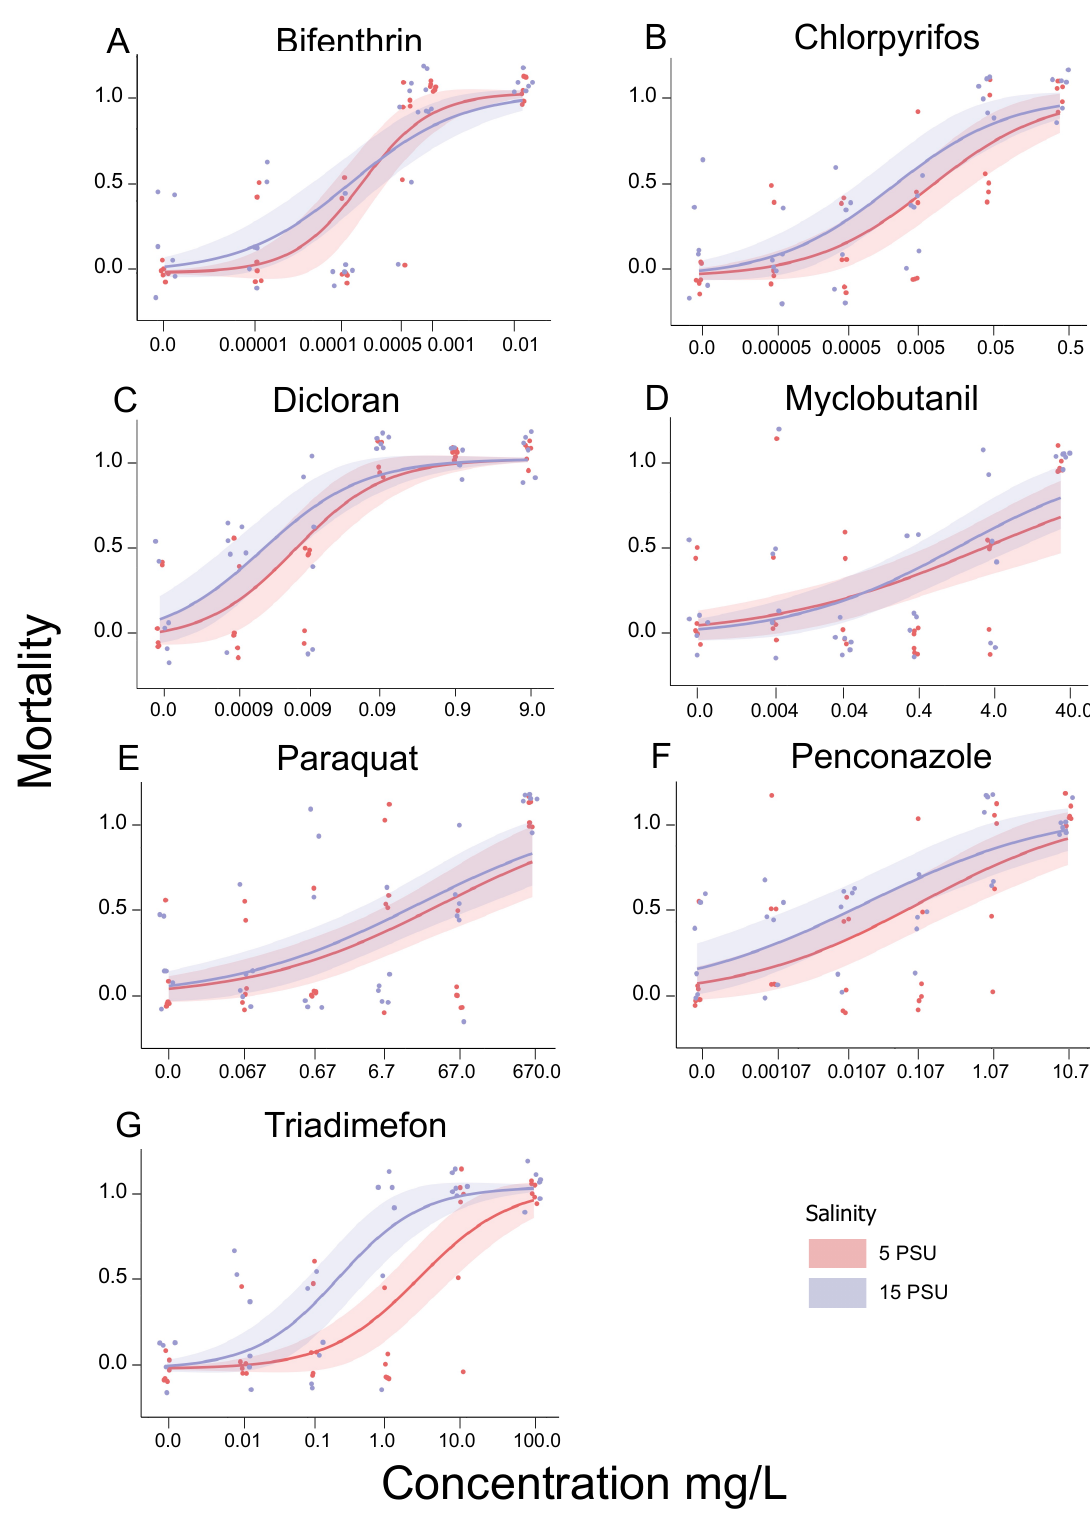
Figure 1. Dose response curves for ( A ) bifenthrin, ( B ) chlorpyrifos, ( C ) dicloran, ( D ) myclobutanil, ( E ) paraquat, ( F ) pen- conazole, and ( G ) triadimefon at 5PSU and 15PSU. Triadimefon had a statistically significant difference in toxicity between the two salinities with higher toxicity at the LC50 value in the 15 PSU exposure. Data points are jittered along the x and y axes for visual clarity.